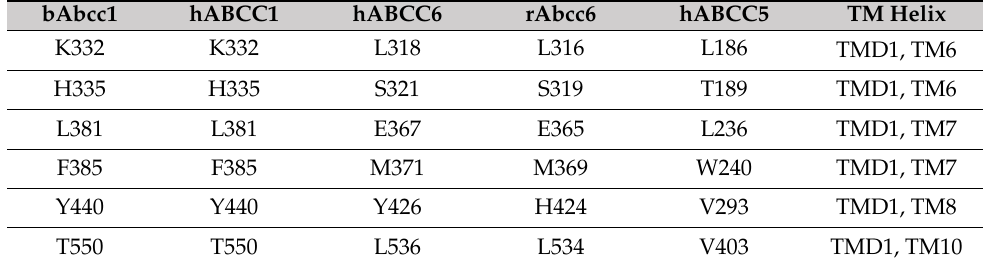
Table 1. Amino acid residues in rat and human ABCC6, human ABCC1 and human ABCC5 at the same positions proposed to form the LTC 4 binding cavity in bAbcc1. In the last column it is indicated to which transmembrane helix (TM) and transmembrane domain (TMD) the residues belong. bAbcc1, bovine Abcc1; hABCC1, human ABCC1; hABCC6, human ABCC6; rAbcc6, rat Abcc6;